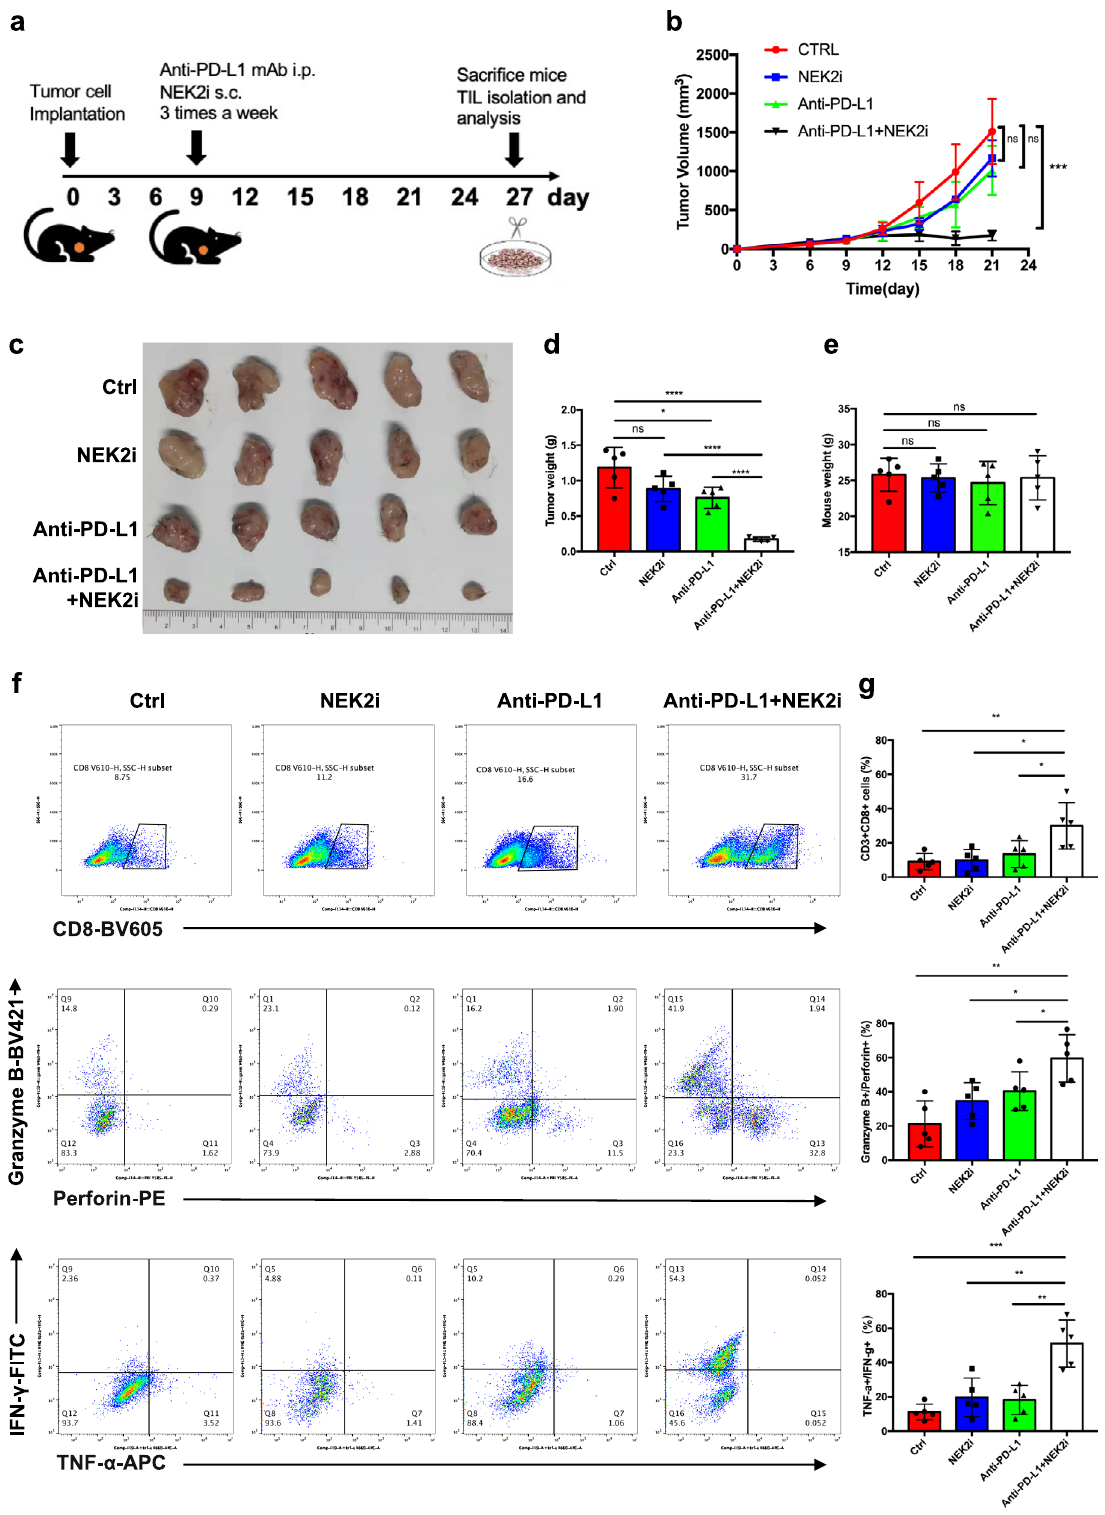
Fig. 7 NEK2 inhibition sensitizes PD-L1-targeted pancreatic cancer immunotherapy. a Schematic protocol of the combination of anti-PD-L1 antibody and NEK2 inhibitor therapy. b Tumor growth curve of mice treated with anti-PD-L1 antibody (200 μ g/mouse), NEK2 inhibitor (100 μ g/mouse), or their combination ( n = 5). c Representative images displaying tumors harvested from mice bearing KPC cells treated with anti-PD-L1 antibody, NEK2 inhibitor, or their combination ( n = 5). d , e Tumor weight and mouse body weight ( n = 5). f , g Flow cytometric analysis and statistical results of lymphocytes that have in fi ltrated the tumors ( n = 5). Results are presented as means ± SD from one representative experiment in b , d , e , and g . All data are representative of three independently performed experiments. * P < 0.05, ** P < 0.01, *** P < 0.001 using a two-tailed t -test; ns: not signi fi